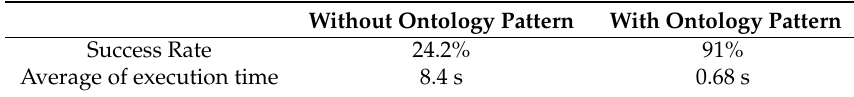
Table 4. Path Finder